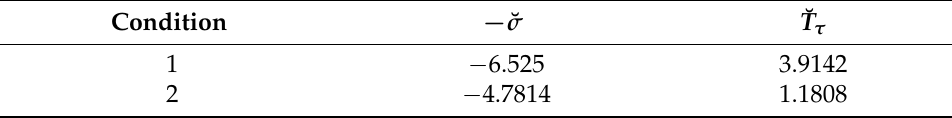
Figure 6. Instantaneous error states for the I part between for the variable ˘ x of (18) and ˘ y of (19) under 30 random initial values for fixed-time synchronization. Table 2. The related values under two